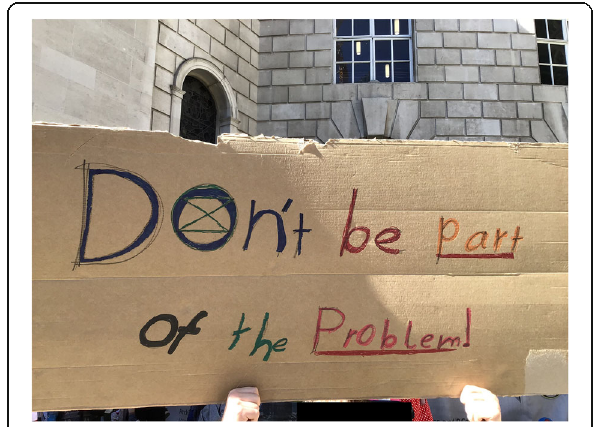
Fig. 1 Protest sign: 'Don't be part of the problem!' Fig. 2. Protest sign: 'WAVES OF